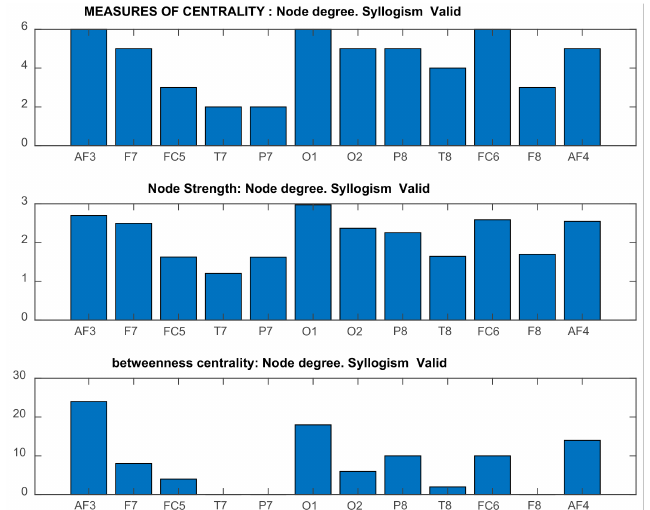
Figure 24. Measures of centrality of the network generated by the brain salience matrix V, for the valid syllogism. The rows and columns of V are the nodes of the network, while the links correspond to elements of the weight matrix W (normalized V and taking its elements with a threshold = 0.20, i.e., retaining the 20% of the strongest links).